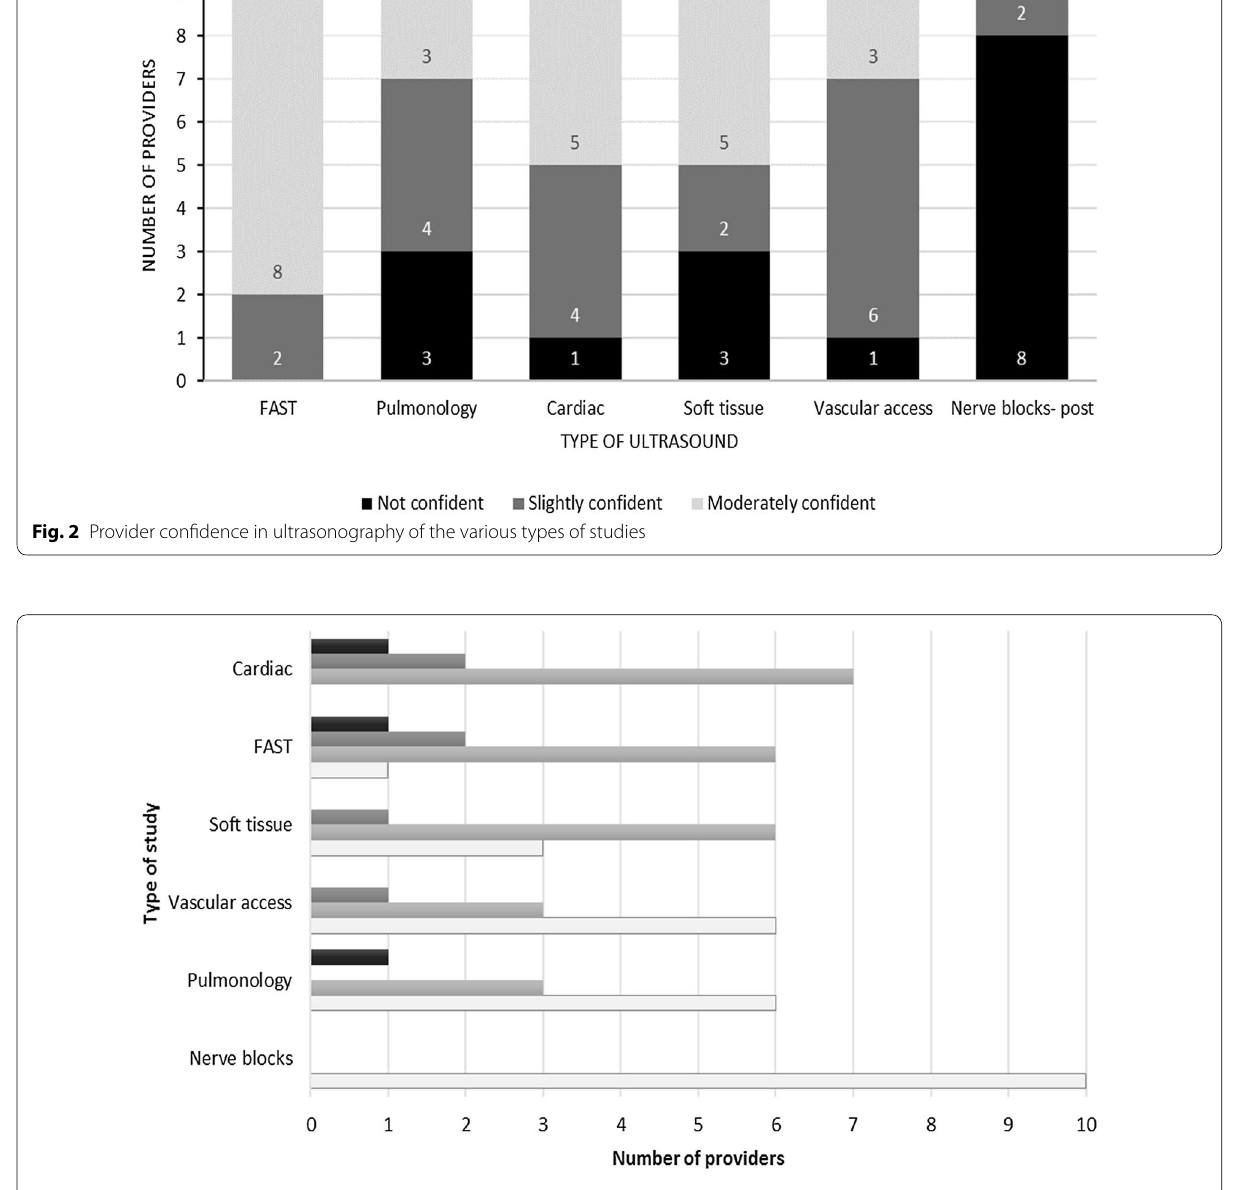
Fig. 3 The frequency of each type of ultrasound conducted throughout the ultrasound